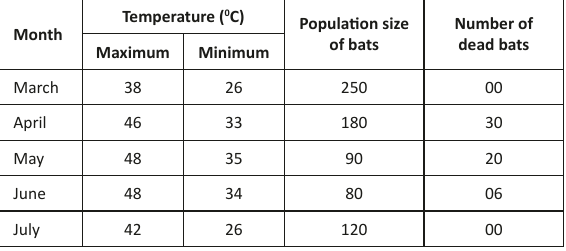
Table 1. Abundance of Indian Flying Fox Pteropus giganteus population along with the number of dead bats and ambient temperatures (both maximum and minimum) recorded from March 2010 to July 2010 from Simla village of Purulia District, West Bengal, India.